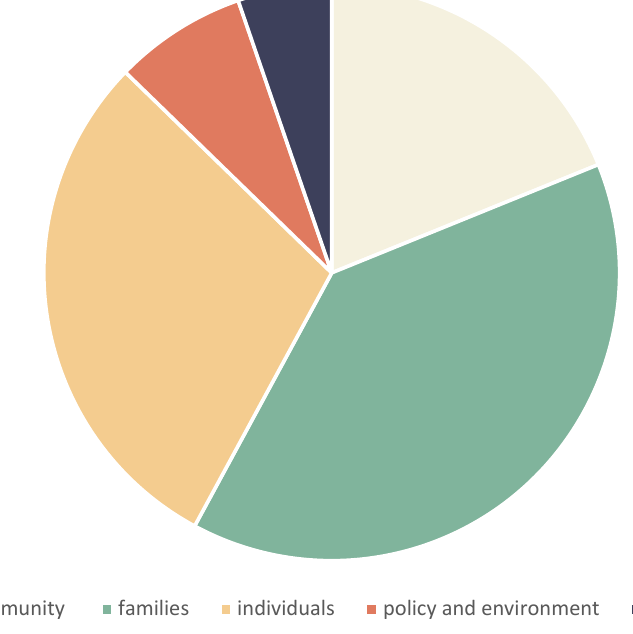
Figure 4. Peer-reviewed literature according to ecological level.